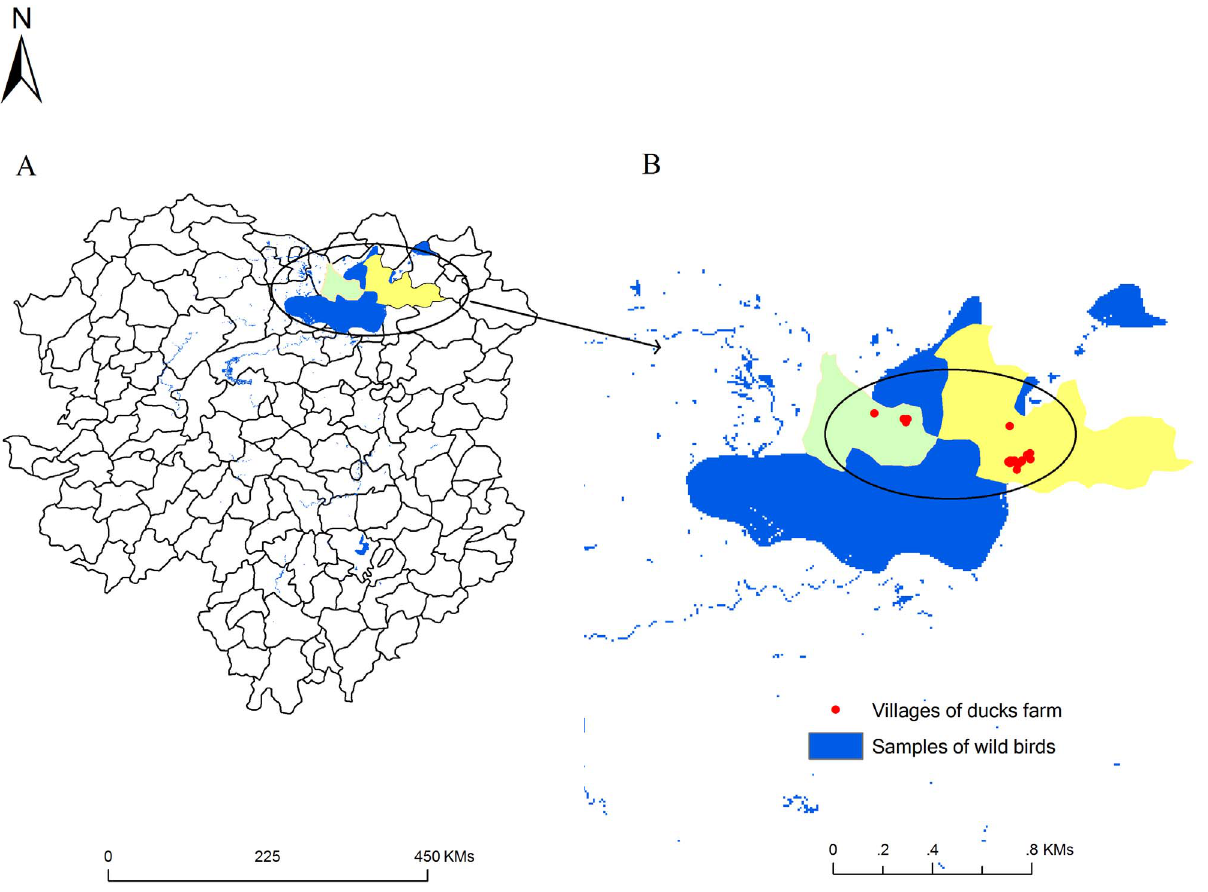
Figure 1. Sample collection sites around the Eastern Dongting Lake area. (A) Hunan Province. Dongting Lake is located to the north of Hunan Province (black circle). (B) Dongting Lake. The black circles indicate sample collection areas. Junshan district (green). Yueyang county (yellow) surrounding the Eastern Dongting Lake area. Villages where environmental samples from duck farms are shown in red.